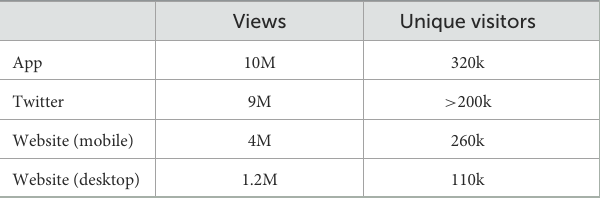
TABLE 1 Number of views and unique visitors to the different components of the LastQuake system on 29 December 2020, the day of the damaging Petrinja (Croatia)